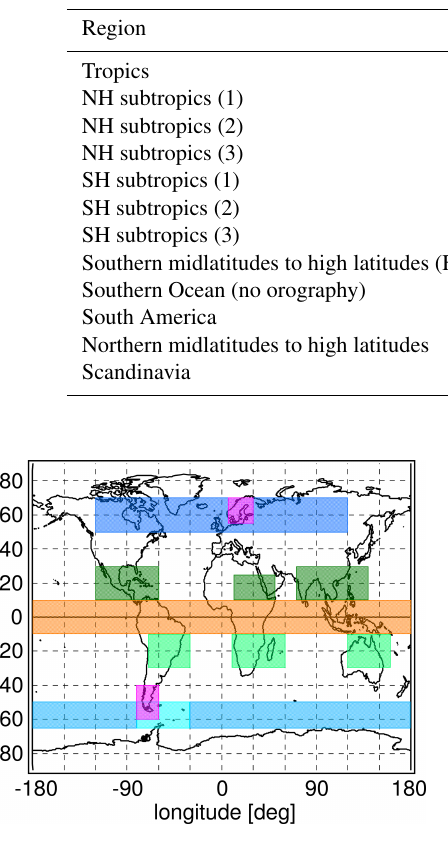
Figure 5. Illustration of the different regions selected for creat- ing PDFs. The latitude–longitude ranges of the different regions are summarized in Table